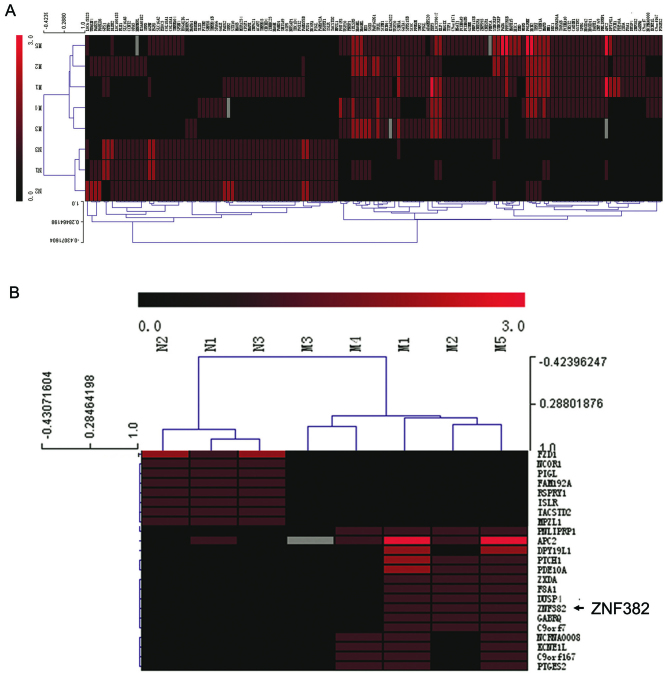
Promoter methylation analysis of pediatric acute myeloid leukemia (AML) samples. (A) Analysis of the methylation status of genes in pediatric AML samples (M1, M2, M3, M4 and M5) and 3 NBM control samples (N1, N2 and N3) using NimbleGen Human DNA Methylation Arrays. Each red box represents the number of methylation peaks (PeakScore) overlapping the promoter region for the corresponding miRNA. The PeakScore is defined as the average -log10 (P-value) from probes within the peak. The scores reflect the probability of positive methylation enrichment. (B) DNA methylation array analysis shows significant promoter zinc finger protein 382 (ZNF382) methylation in AML samples and no ZNF382 methylation in NBM control samples.